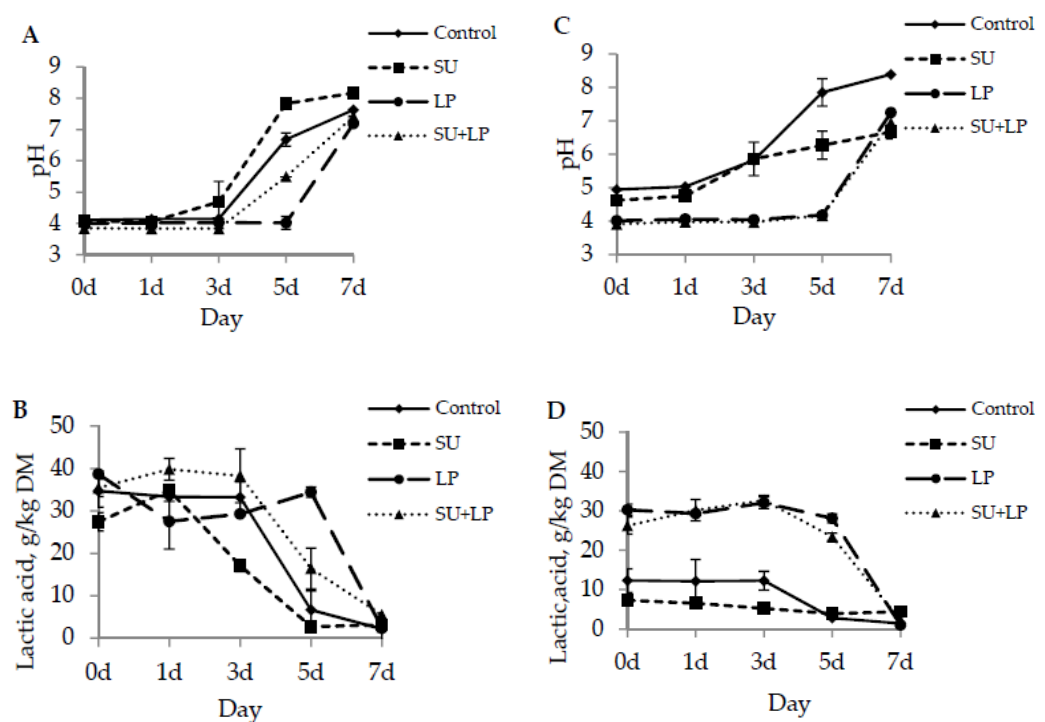
Figure 3. Dynamic changes in the pH value during aerobic exposure of L . chinensis silage treated with different additives at 1–2 cm length ( A ) and 4–5 cm length ( C ). Dynamic changes in the lactic acid content during aerobic exposure of L . chinensis silage with different additives at 1–2 cm length ( B ) and 4–5 cm length ( D ). SU, sucrose; LP, Lactobacillus plantarum ; DM, dry matter .